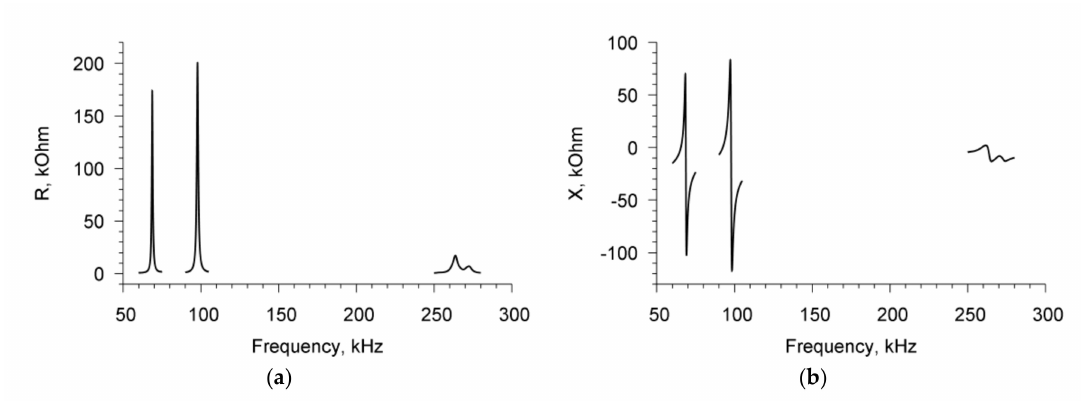
Figure 2. The frequency dependencies of the real ( a ) and imaginary ( b ) parts of the electrical impedance of PZT resonator with empty liquid